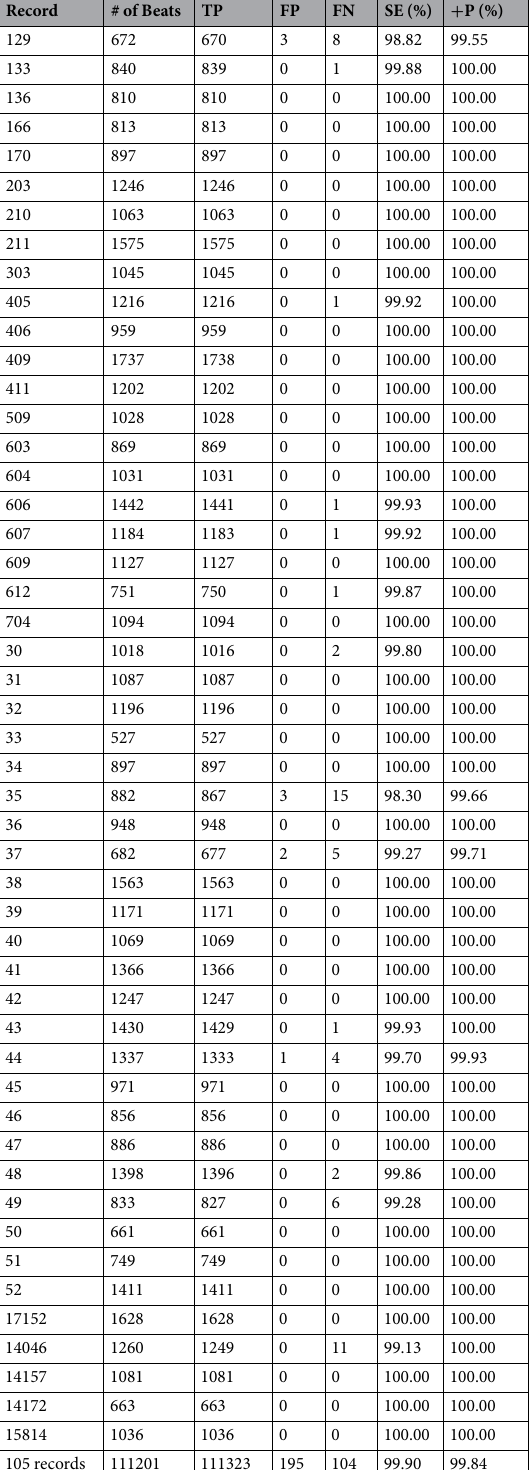
Table 5. Performance of Method III using B / K = 4.875 on the QT database. The results were obtained using the optimal values of B and K , which are 390 Hz and 80 Hz, respectively. TP stands for true positives (the number of QRS complexes detected as QRS complexes), FN stands for false negatives (the number of QRS complexes which have not been detected), FP stands for the number of false positives (non-QRS complexes detected as QRS complexes), SE stands for sensitivity, and + P stands for positive